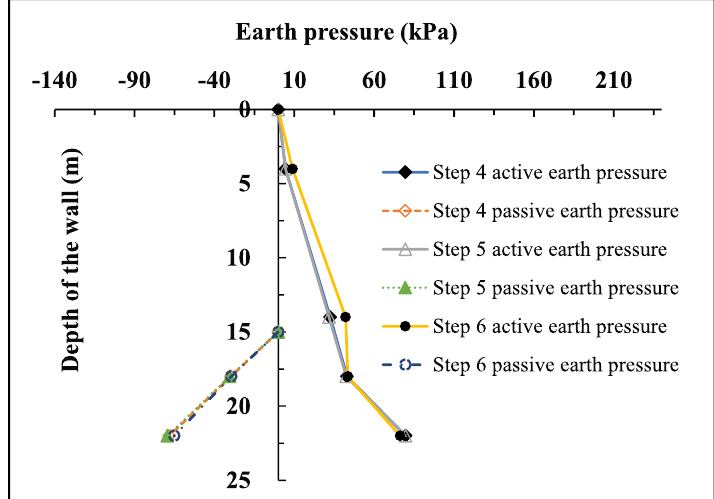
Figure 14. Earth pressure distribution of wall No. 2 from Step 4 to Step 6.